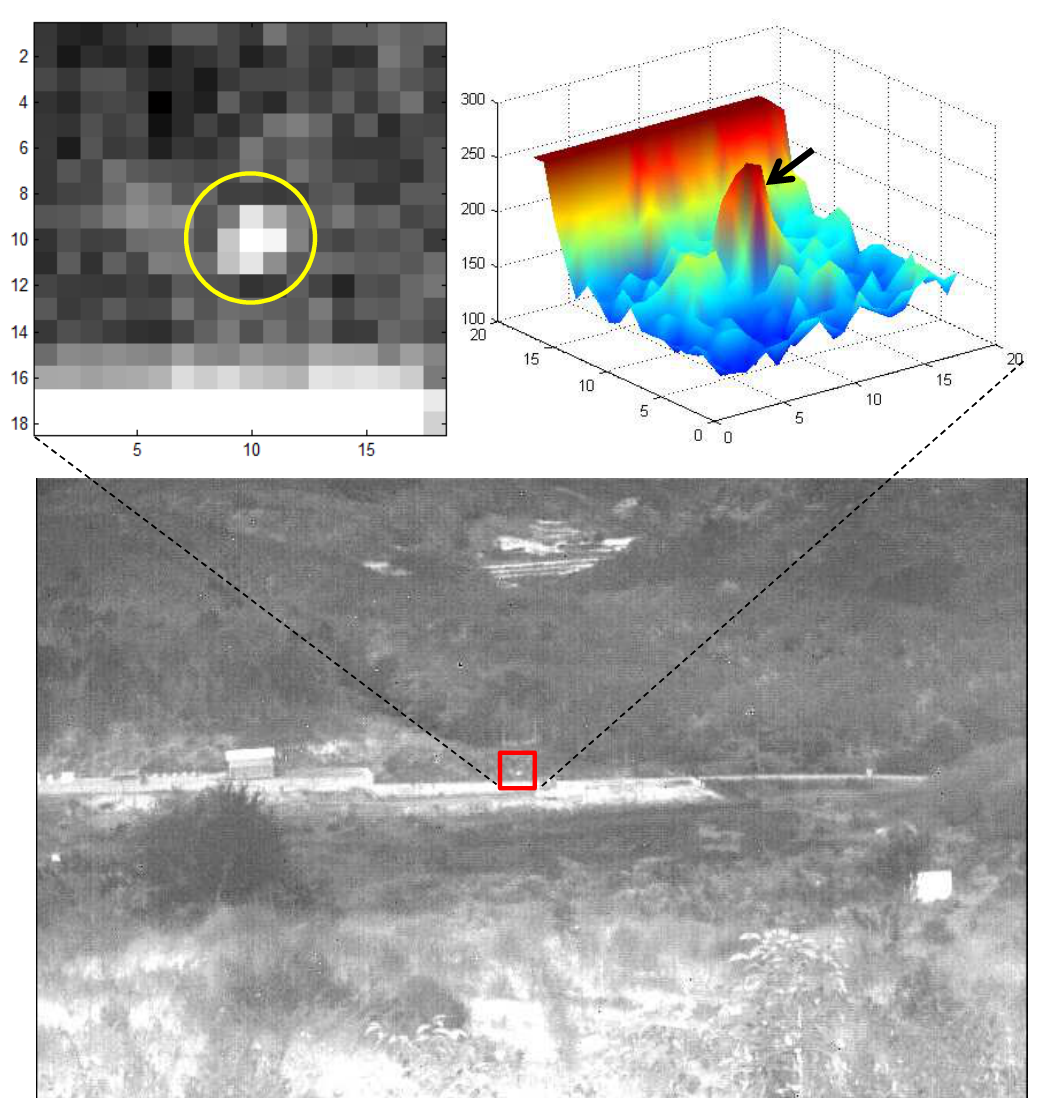
Figure 1. Infrared small target detection problem in a next generation active protection system